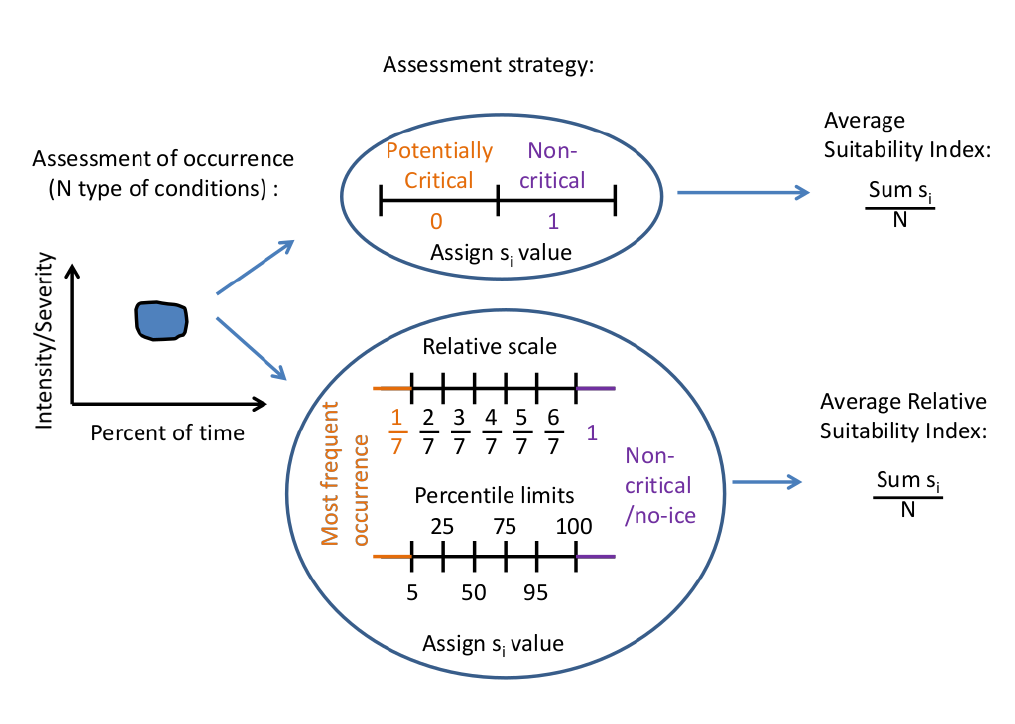
Figure 2. Sketch of the methodology going from geo-spatial data to classifications based on either yes/no (potentially critical/non-critical) conditions or on a relative scale based on the frequency of occurrence or intensity of the aspect considered. For the relative scale, a value of one can be assigned to all areas for which a non-occurrence of the aspect considered has taken place, to result in an Suitability Index (SI) ranging between zero and one, or six classes can be presented based on percentile limits. Averaging across suitability indexes corresponding to many different choices to formulate an average SI is advantageous as a first assessment of metocean conditions for a region, before specific choices about technology and marine infrastructure to be used in a project have been made. All individual SI results for different choices will however also be saved for a full description of metocean conditions, which may be needed at a project